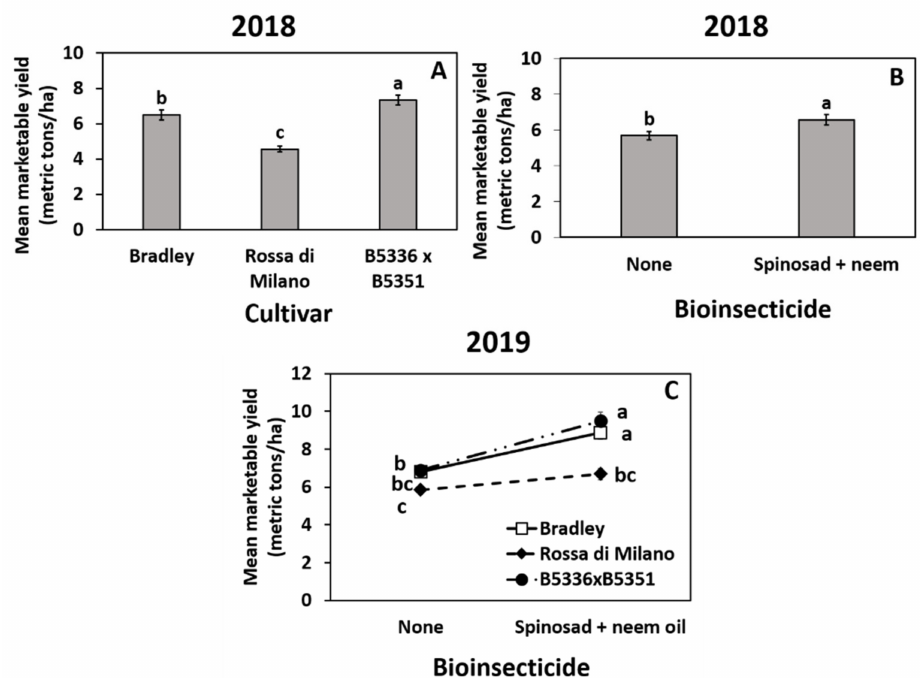
Figure 3. Highest order significant effects of cultivar ( A ), biopesticide ( B ), and the interaction of cultivar × biopesticide ( C ) on total mean ( ± SE) marketable onion yield (metric tons per ha) in 2018 ( A , B ) and 2019 ( C ) in Geneva, New York, USA. The standard errors at some time points are small and may appear behind the point marker. Means with different letters are significantly different at α = 0.05 using Tukey’s LSD post hoc